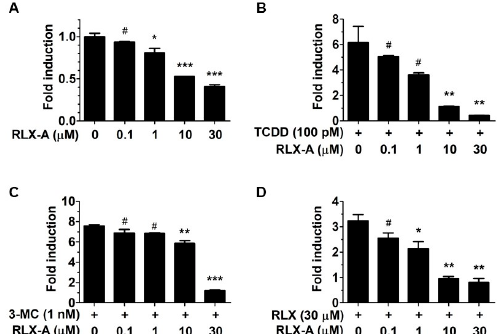
Figure 2. Analog A antagonizes AhR activation. The antagonistic activity of analog A was analyzed by AhRE-luciferase reporter assay. ( A ) Hepa1 cells transfected with AhRE were incubated for 12 h with analog A or vehicle as indicated and the luciferase reporter activity was measured by Luciferase assay system. The data was normalized to cell viability, which was determined with CellTiter GLO assay performed simultaneously. ( B – D ) Cells were pre-incubated for 1 h with 0.1% DMSO or analog A at the indicated concentrations (0.1 µM, 1 µM, 10 µM, and 30 µM) followed by treatment for 12 h with 100 pM TCDD ( B ), 1 nM 3-methylcholanthrene ( C ), or 30 µM raloxifene ( D ). The data are presented as fold inductions, and are the mean ± SEM ( n = 2). Data were analyzed by one-way ANOVA followed by Dunnett test’s post-hoc test. Differences with p values less than 0.05 was regarded as statistically significant. *, p < 0.05; **, p < 0.01; ***, p < 0.001; #, not significant.